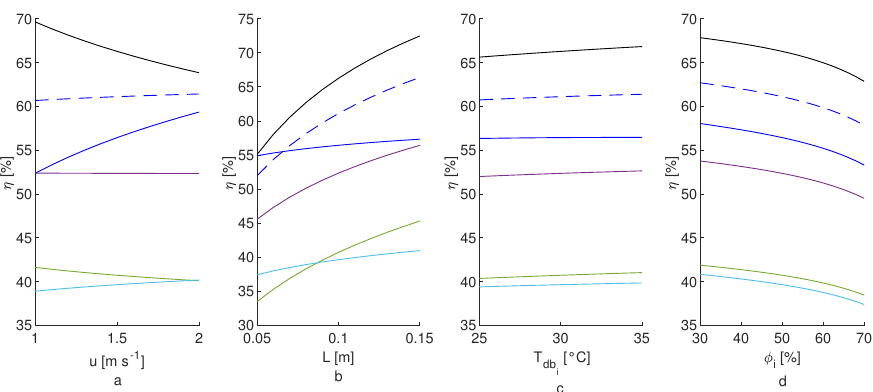
Figure 5. Comparison of pad cooling efficiency ( η ) of each pad analysed. ( a ) As function of inlet air velocity ( u ). ( b ) As function of pad thickness ( L ). ( c ) As function of dry-bulb temperature of inlet air ( T db ). ( d ) As function of relative humidity of inlet air ( φ i ). For each plot the other parameters i remained constants: u = 1.5 m s − 1 , L = 0.1 m, T db = 30 ◦ C and φ i = 60%. CL : solid black line; CS 1 : i blue solid line; CS 2 : blue dashed line; BC : red solid line; PS 1 : magenta solid line; PS 2 : magenta dashed